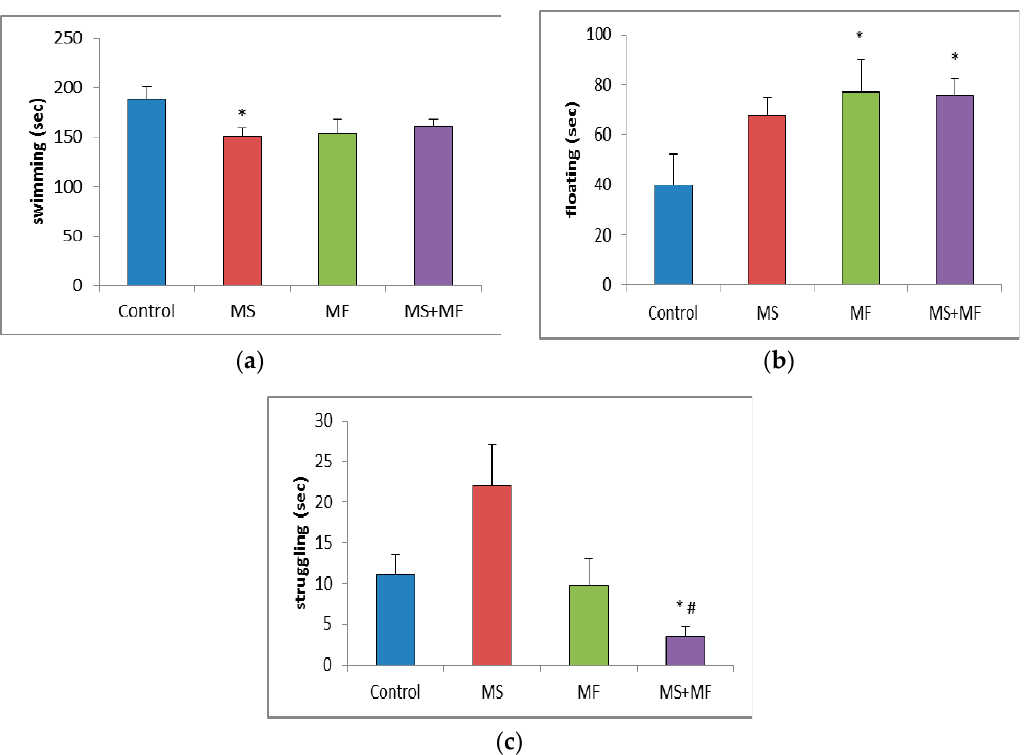
Figure 5. Effect of various combinations of stress factors on the parameters evaluated in the forced swim test: ( a ) swimming, ( b ) floating and ( c ) struggling time (seconds). The values are mean ± S.E.M ( n = 10 per group, * p < 0.05 vs. control and # p < 0.05 vs. MS group (MS = maternal separation, MF = multifactorial stress).